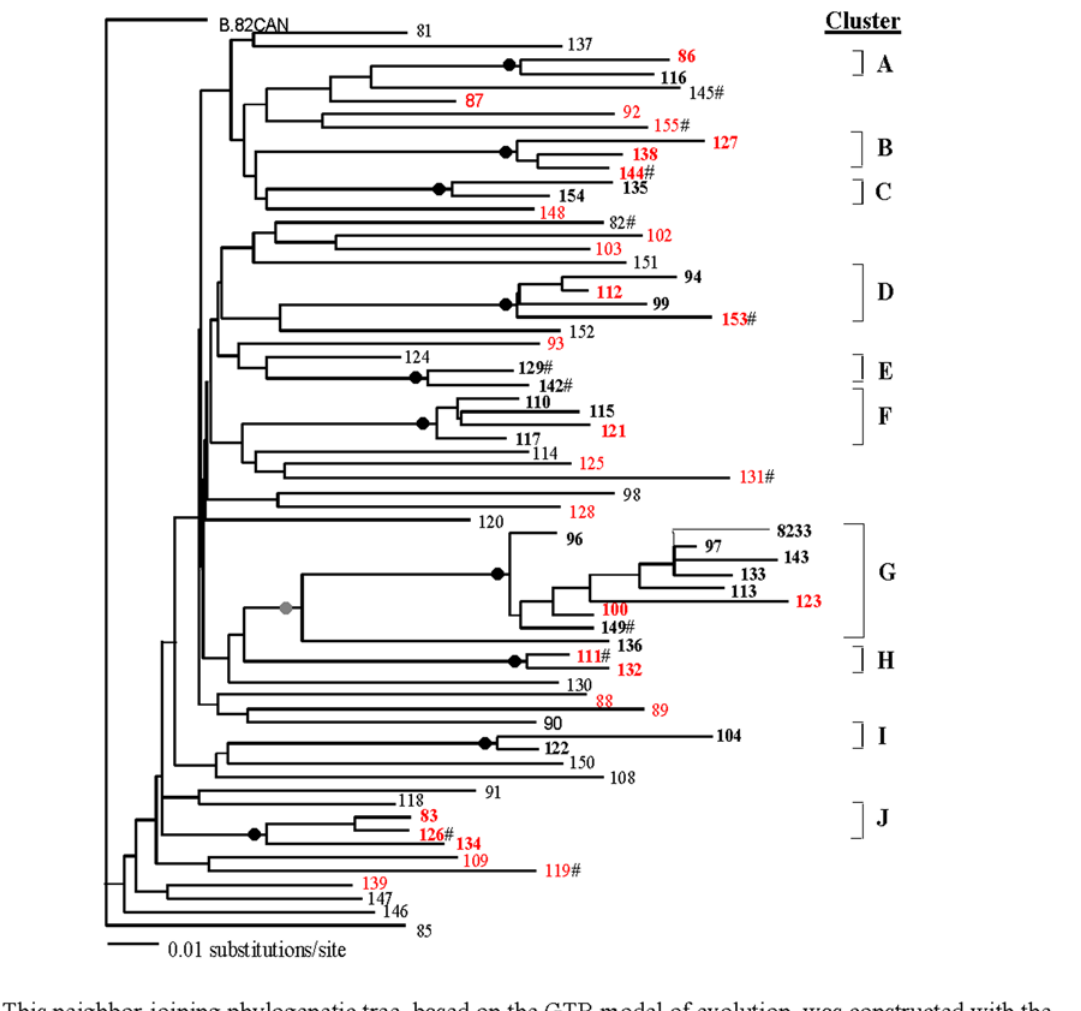
Figure 2. Genetic Analysis of Combined p17 and gp41 Sequences of HIV Strains from 67 Seroconverters and One Trace Contact, Georgia State Prison system, United States, 1988–2005.